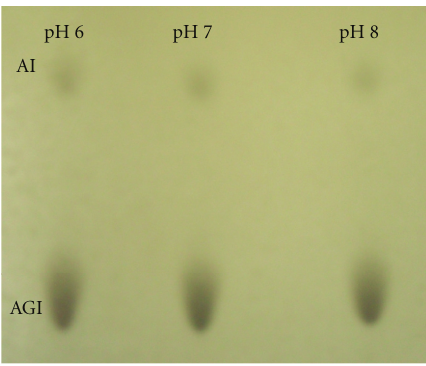
Figure 2: TLC results of PLMF from A. pernix grown at di ff erent pH as marked. AI and AGI stands for C 25,25 -archetidylinositol and C 25,25 -archetidyl(glucosyl)inositol,